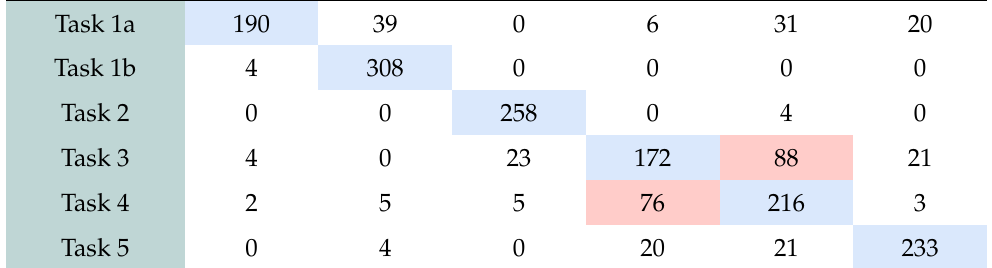
Table 2. Confusion matrix for Participant 5, based on the 6 label classification.